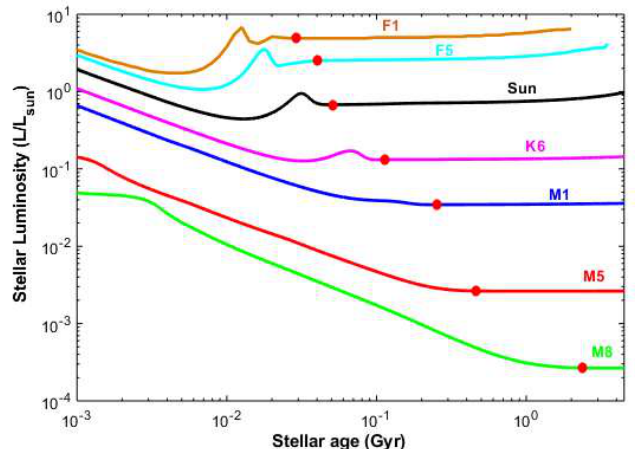
Figure 10. Evolution of stellar luminosity for F–M stars (F1, F5, Sun, K6, M1, M5, and M8) using Barrafe et al. [184] stellar evolutionary models. When the star reaches the main-sequence (red points) the luminosity curve flattens (updated from Ramirez and Kaltenegger [51]).